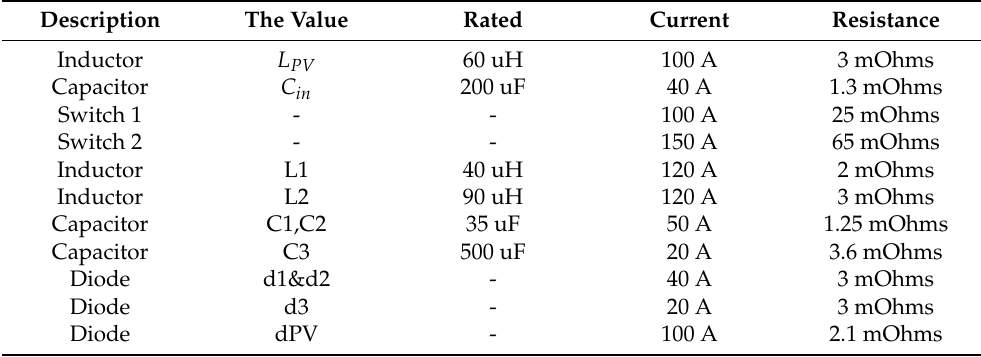
Table 1. The selected components